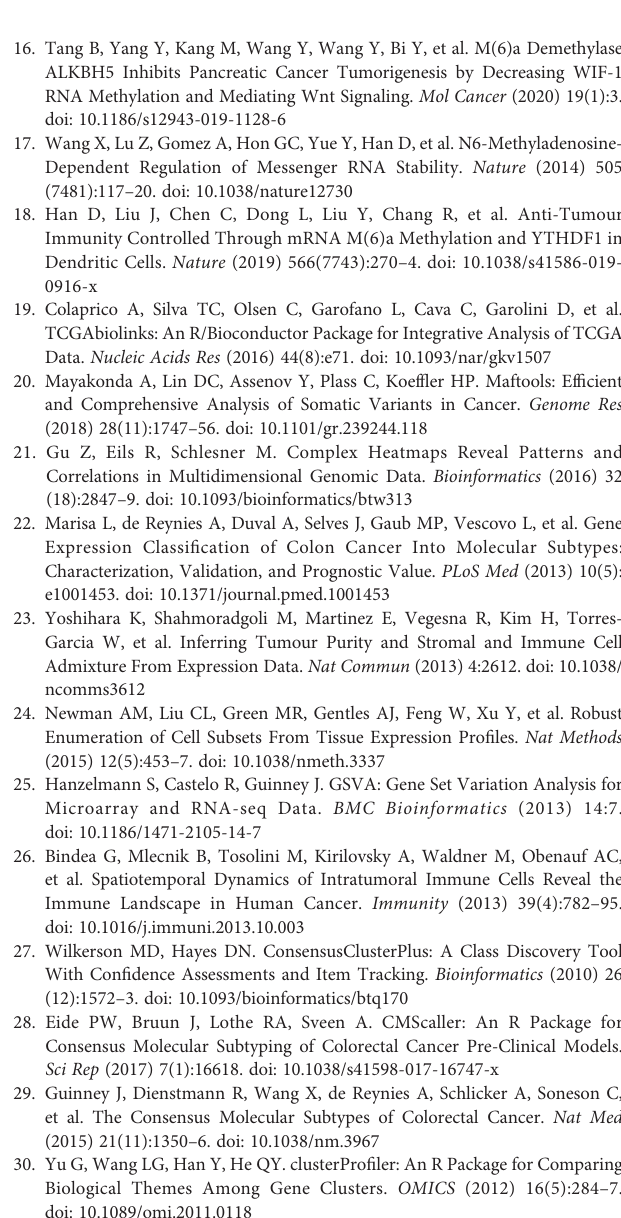
Supplementary Figure 1 | Heatmap corresponding to the consensus matrix for k = 2 using consensus clustering. Supplementary Figure 2 | Relationship between the two clusters and the consensus molecular subtypes (CMS). Supplementary Figure 3 | Survival analysis of 2 clusters. Supplementary Figure 4 | Heatmap shows overall condition of 28 immune cells subtypes between 2